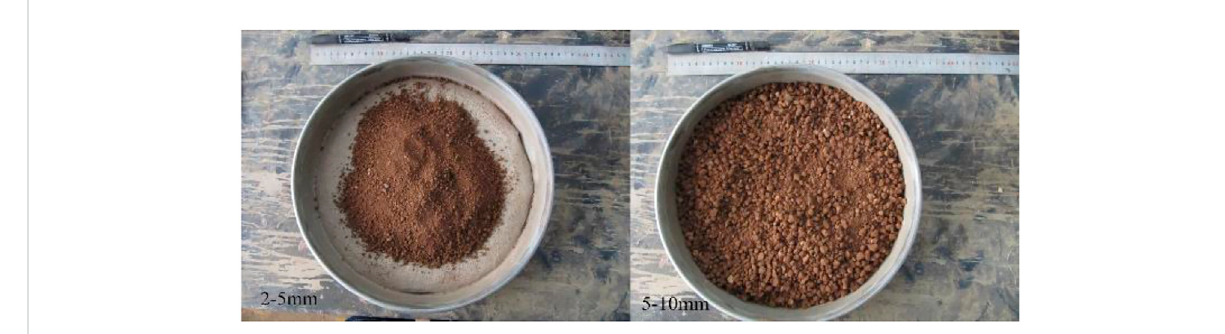
FIGURE 1 Rock blocks inside the S-RM sample used in the laboratory test.